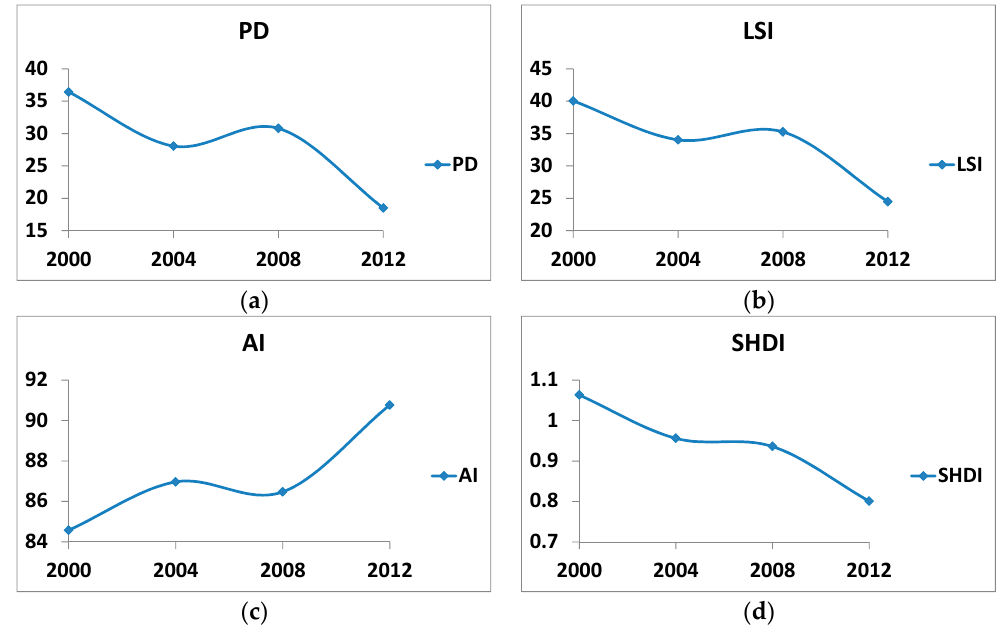
Figure 6. Landscape-level metrics change from 2000 to 2012: ( a ) PD; ( b ) LSI; ( c ) AI; ( d ) SHDI. (Note: PD = Patch Density, LSI = Landscape Shape Index, AI = Aggregation Index, SHDI = Shannon’s Diversity Index).